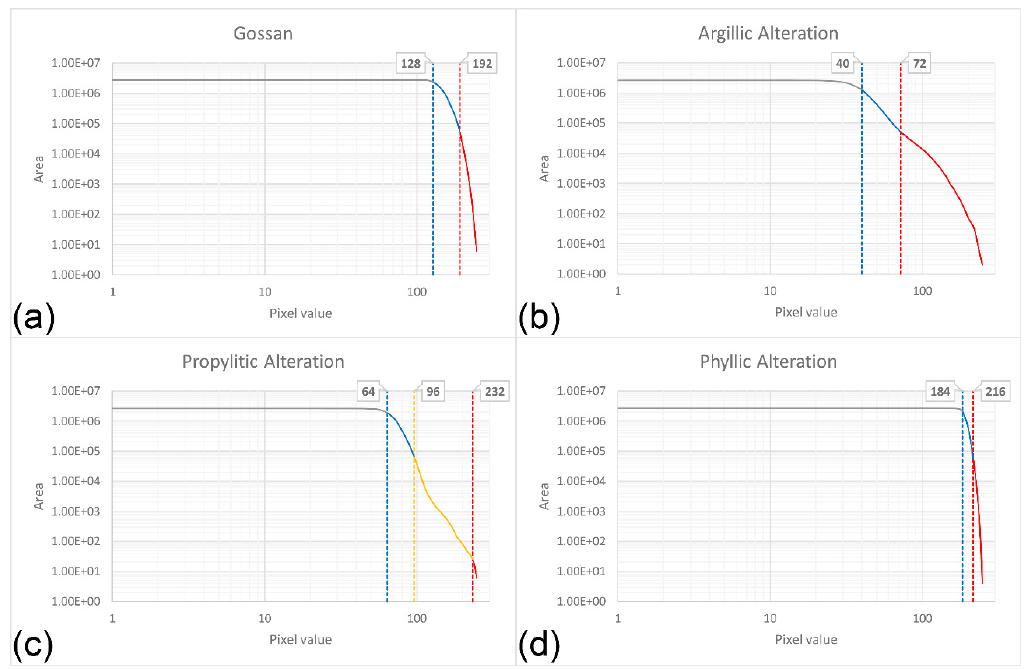
Figure 7. Logarithmic scaled plots of area versus pixel values for the selected independent components for enhancing the (a) gossans, (b) argillic, (c) propylitic, and (d) phyllic alteration zones.